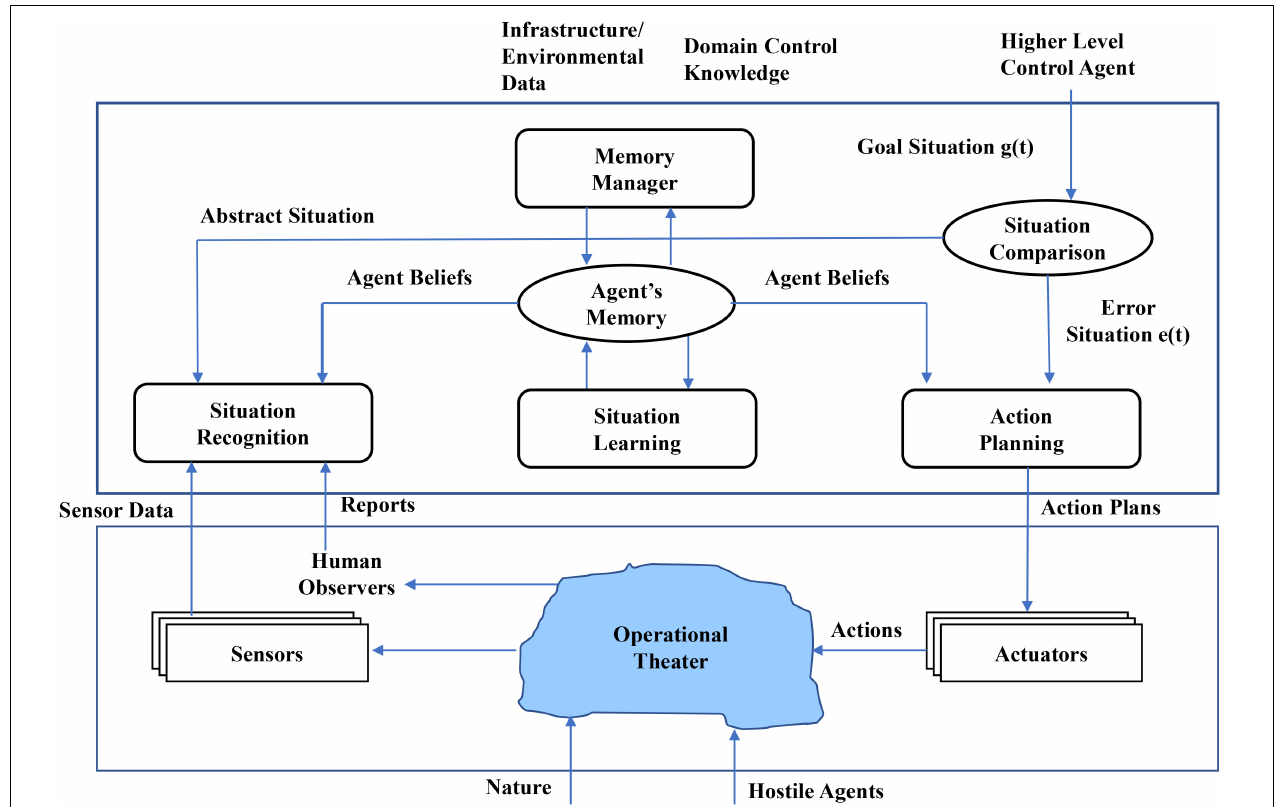
FIGURE 1 | Concept of cognitive situational control derived from Jakobson